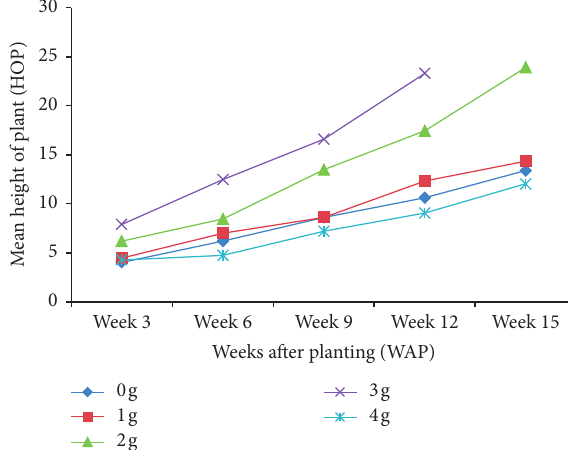
Figure 2: Mean plant height of Punica granatum with different treatments.